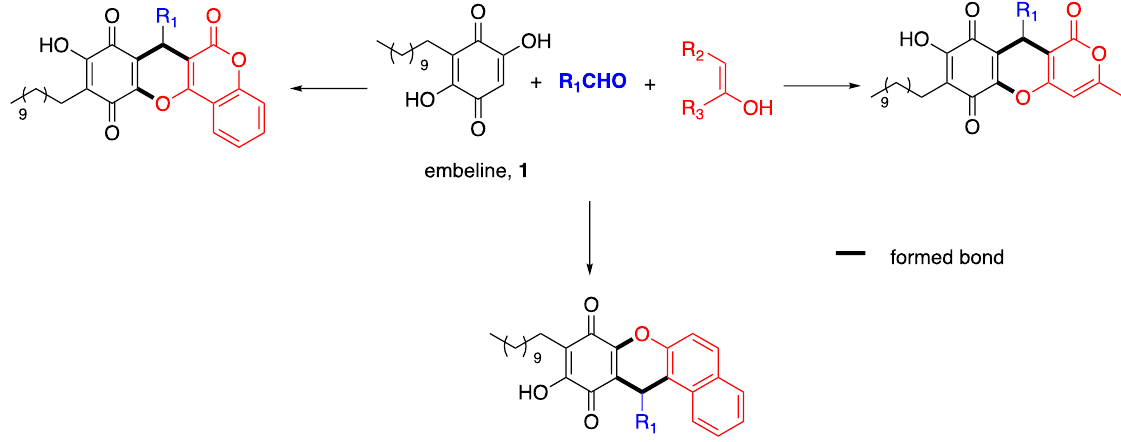
Scheme 1. Structure of embelin-privileged structure conjugates.